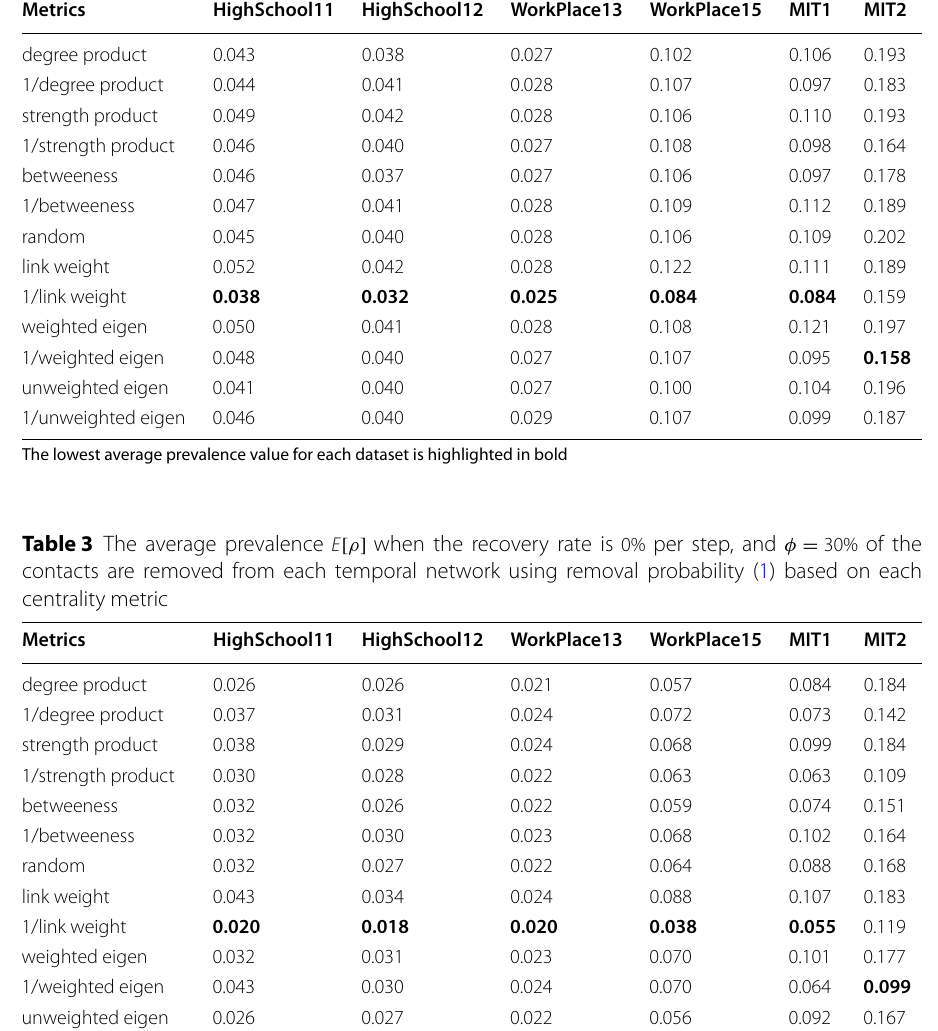
Table 2 The average prevalence E [ ρ ] when the recovery rate is γ = 0% per step, and φ = 10% of the contacts are removed from each temporal network using removal probability (1) based on each centrality metric Metrics